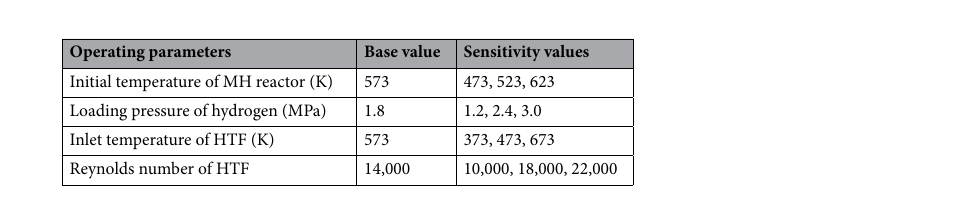
Table 3. Operating conditions for sensitivity